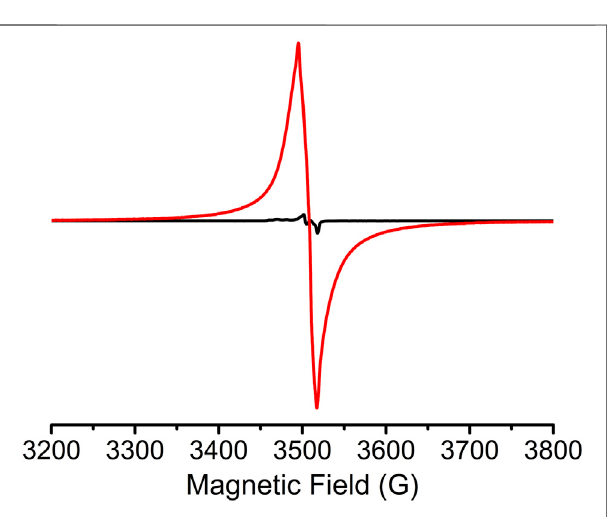
Frontiers in Chemistry |